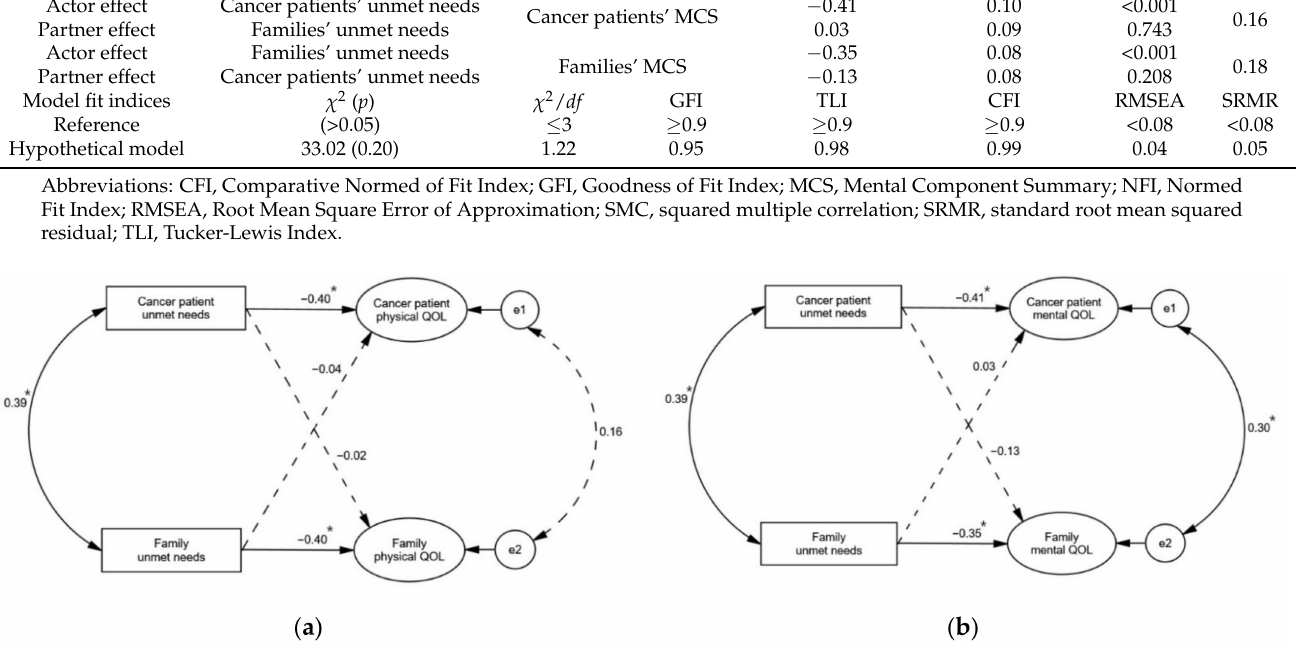
Figure 2. Final models. ( a ) Physical QOL; ( b ) Mental QOL. Note. Dashed arrows represent statistical non − significance; * p <